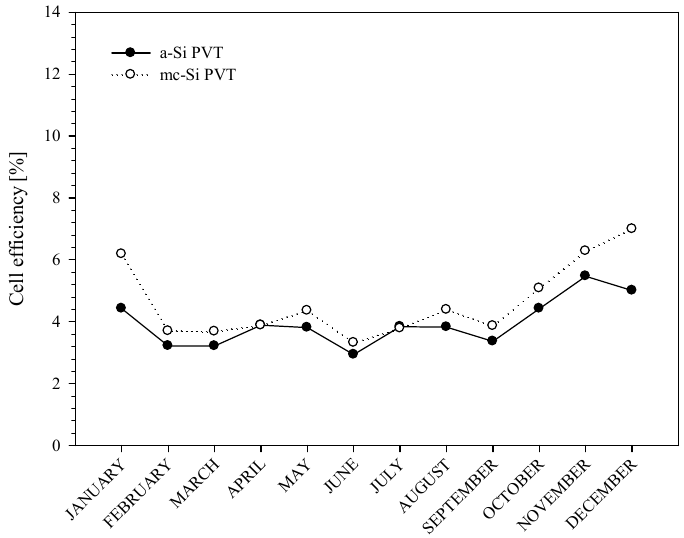
Figure 12. Cell efficiency of experimental PVT collector.